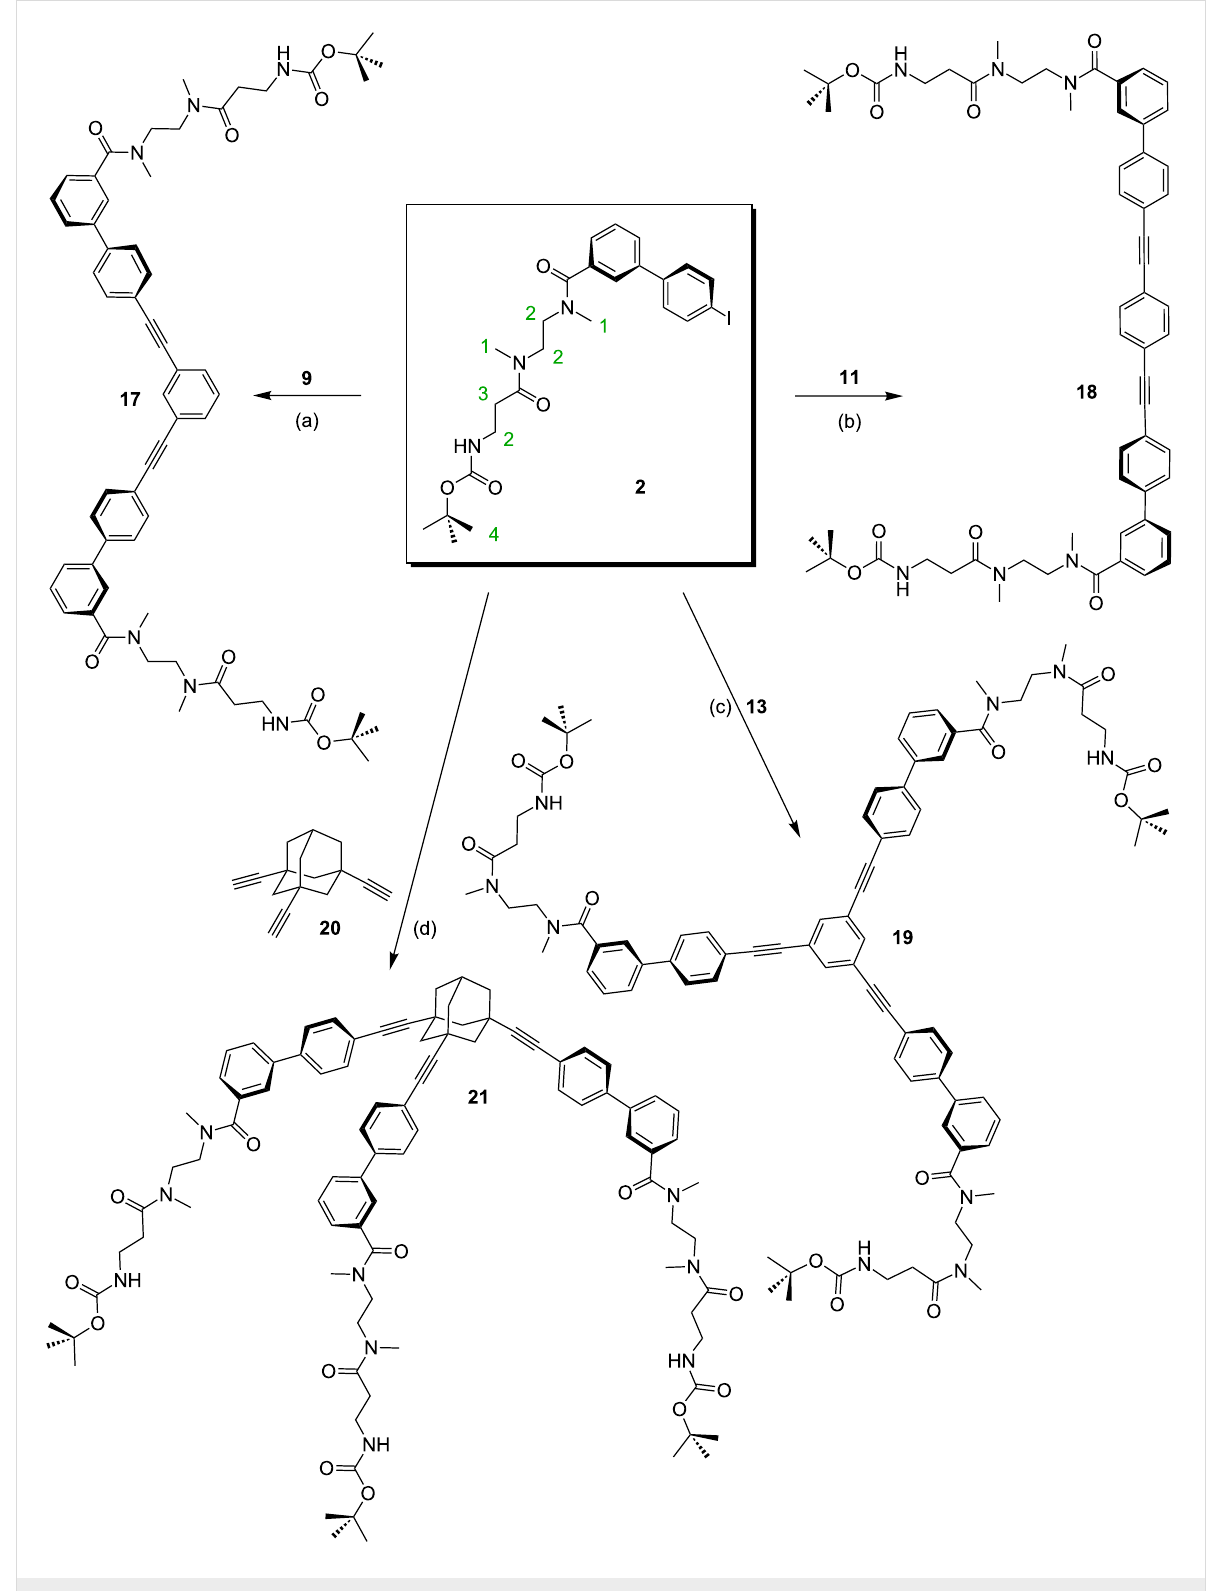
Scheme 5: Synthesis of a series of multivalent guests starting from the axle 2 . (a), (b), (c), (d): Pd 2 (dba) 3 , CuI, PPh 3 , NEt 3 , DMF, 70 °C, 3 d; 32% ( 17 ), 37% ( 18 ), 24% ( 19 ), 64% ( 21 ),